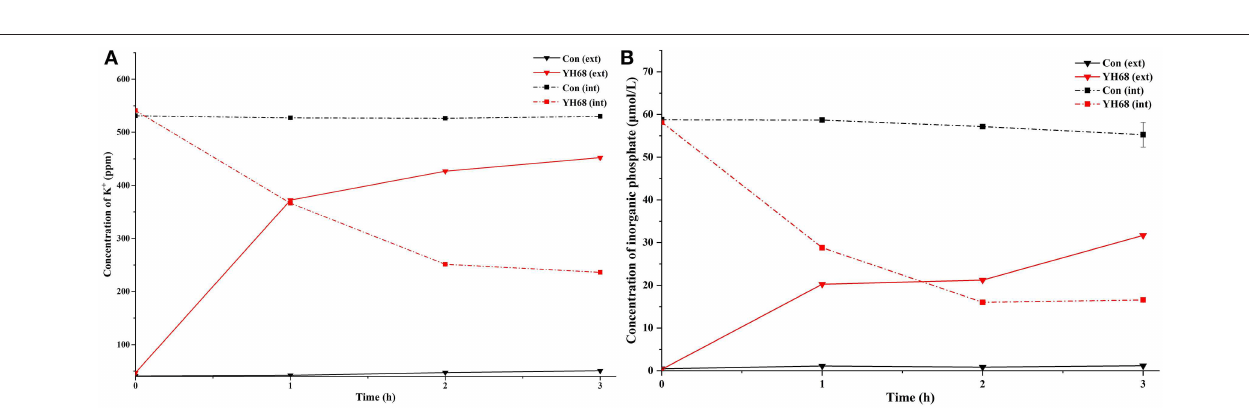
FIGURE 5 | Intracellular (int) and extracellular (ext) K + (A) and inorganic phosphate (B) levels in C. difficile ATCC 9689 cells.